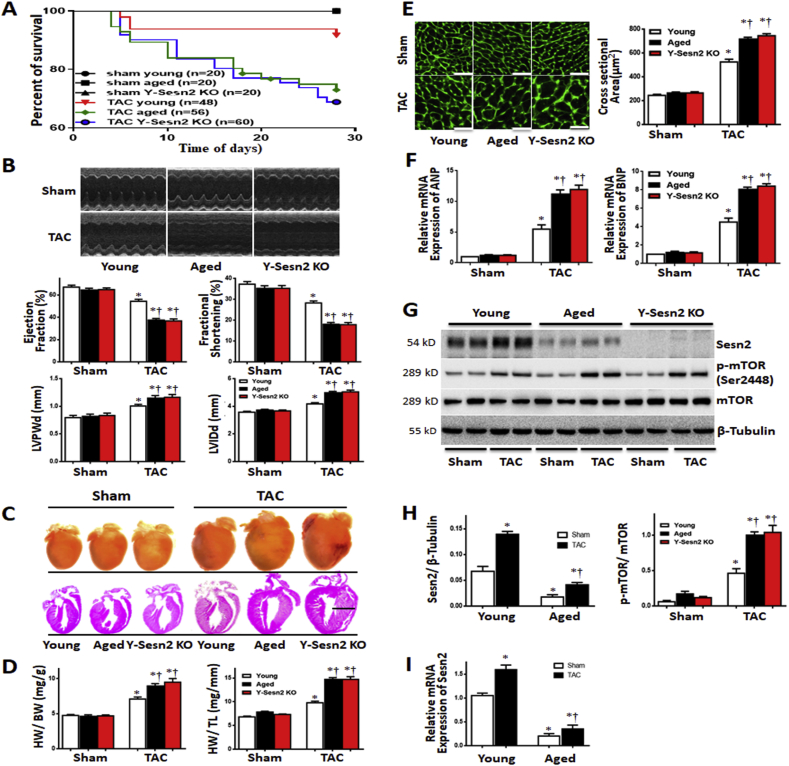
Aged WT and Y-Sesn2 KO hearts show similar responses to pressure overload induced by transverse aortic constriction (TAC). (A) Percent survival rates for young WT(Young), aged WT(Aged), and Y-Sesn2 KO mice subjected to sham operation or TAC. Sample size per group noted in figure. (B) Representative echocardiography results for Y-Sesn2 KO, aged WT, and young WT mice at 4 weeks after TAC or sham surgery. The EF, FS, left ventricular posterior wall at end-diastole (LVPWd), and left ventricular internal diameter at end-diastole (LVIDd) were quantified from echocardiography (n = 15–20 per group). (C) Representative images of whole hearts (scale bar, 2 mm) and hematoxylin–eosin (scale bar, 2 mm) staining images of Y-Sesn2 KO, aged WT, and young WT mice at 4 weeks after TAC or sham surgery. (D) Heart weight/body weight (HW/BW) ratios and heart weight/tibial length (HW/TL) ratios of Y-Sesn2 KO, aged WT, and young WT mice at 4 weeks after TAC or sham surgery (n = 15–20 per group). (E) Representative wheat germ agglutinin (scale bars, 50 μm) staining images and quantification of cardiomyocyte size in Y-Sesn2 KO, aged WT, and young WT mice at 4 weeks after TAC or sham surgery (n = 30–40 per group). (F) mRNA expression analysis of ANP and BNP in Y-Sesn2 KO, aged WT, and young WT mice at 4 weeks after TAC or sham surgery (n = 5–6 per group). (G) Immunoblot for the indicated proteins from hearts of Y-Sesn2 KO, aged WT, and young WT mice at 4 weeks after TAC or sham surgery. (H) Quantification of Sesn2 protein in aged WT and young WT mice at 4 weeks after TAC or Sham surgery, as well as quantification of phospho-mammalian target of rapamycin (p-mTOR)/mTOR expression in Y-Sesn2 KO, aged WT, and young WT mice at 4 weeks after TAC or sham surgery (n = 5–6 per group). (I) Relative Sesn2 mRNA expression levels in aged WT and young WT mice at 4 weeks after TAC or sham surgery. (n = 5–6 per group). Values are mean ± SEM, *p < 0.05 vs. Sham group; †p < 0.05 vs. corresponding young WT group.